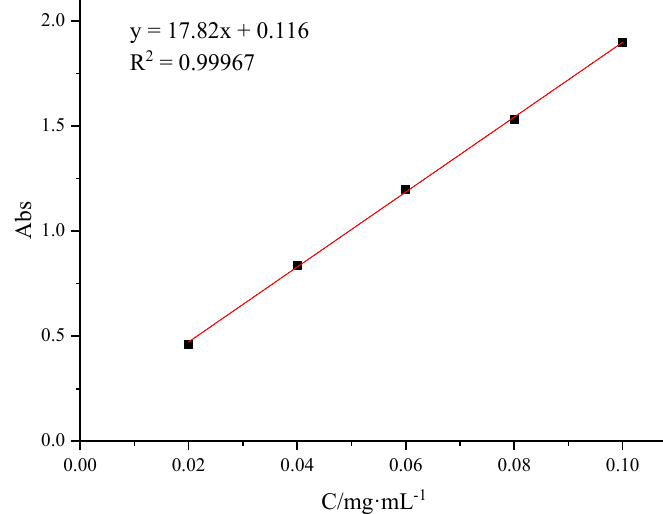
Figure 10. Standard curve of amamubicin hydrochloride.